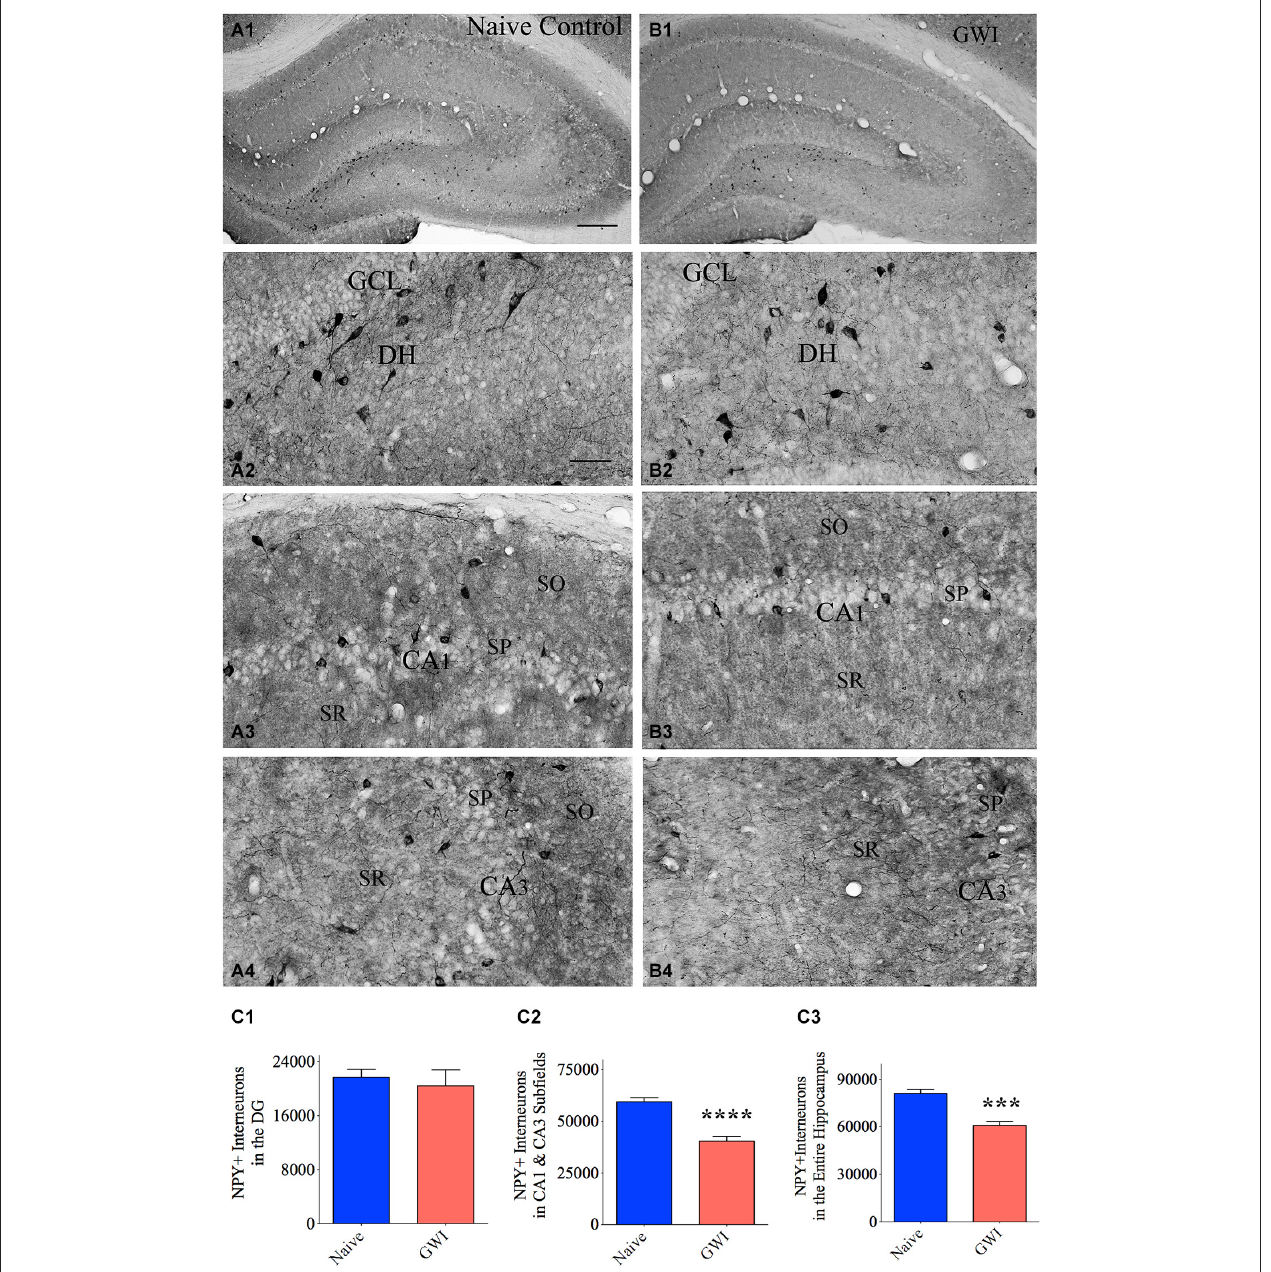
density of NPY+ interneuron cell bodies is apparent in the CA1 and CA3 subfields of a GWI rat (B3, B4) , in comparison to respective regions from a naive control rat (A3, A4) . Scale bar (A1) and (B1) = 500 µ m; (A2–A4) and (B2–B4) = 100 µ m. Bar charts in (C1–C3) compare numbers of NPY+ interneurons in the DG (C1) , CA1 and CA3 subfields (C2) and the entire hippocampus (C3) between naive control rats and GWI-rats. *** p < 0.001; **** p < 0.0001 (two tailed, unpaired Student’s t -test). DH, dentate hilus; GCL, granule cell layer; SO, stratum oriens, SP, stratum pyramidale; SR, stratum